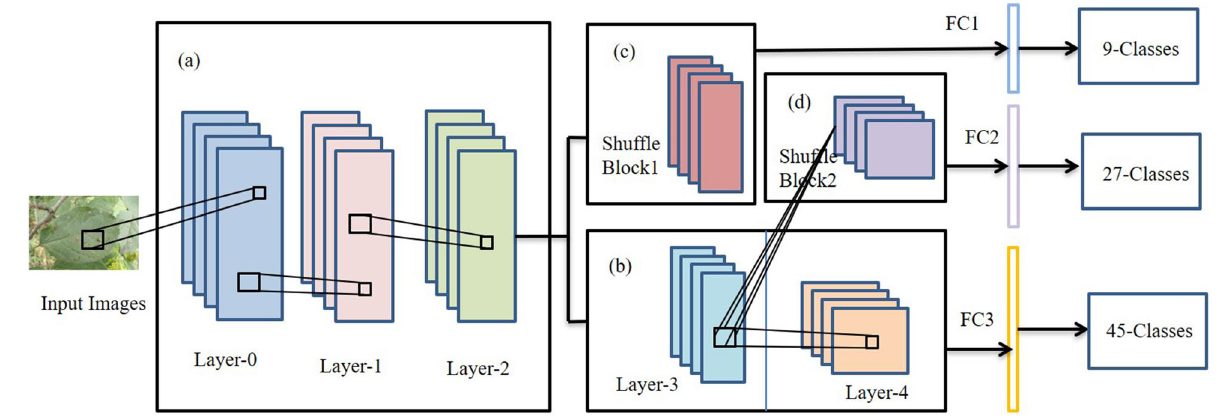
Figure 4. The architecture of PD2SE-Net. Five parts: ( a ) parameter sharing layer; ( b ) the third layer is the parameter sharing layer between the fourth layer and shuffling block 2, and the fourth layer is the high- dimensional feature extractor for severity estimation; ( c ) a feature extractor for plant species recognition; ( d ) feature extractor for plant disease diagnosis; ( e ) fully connected layers 3